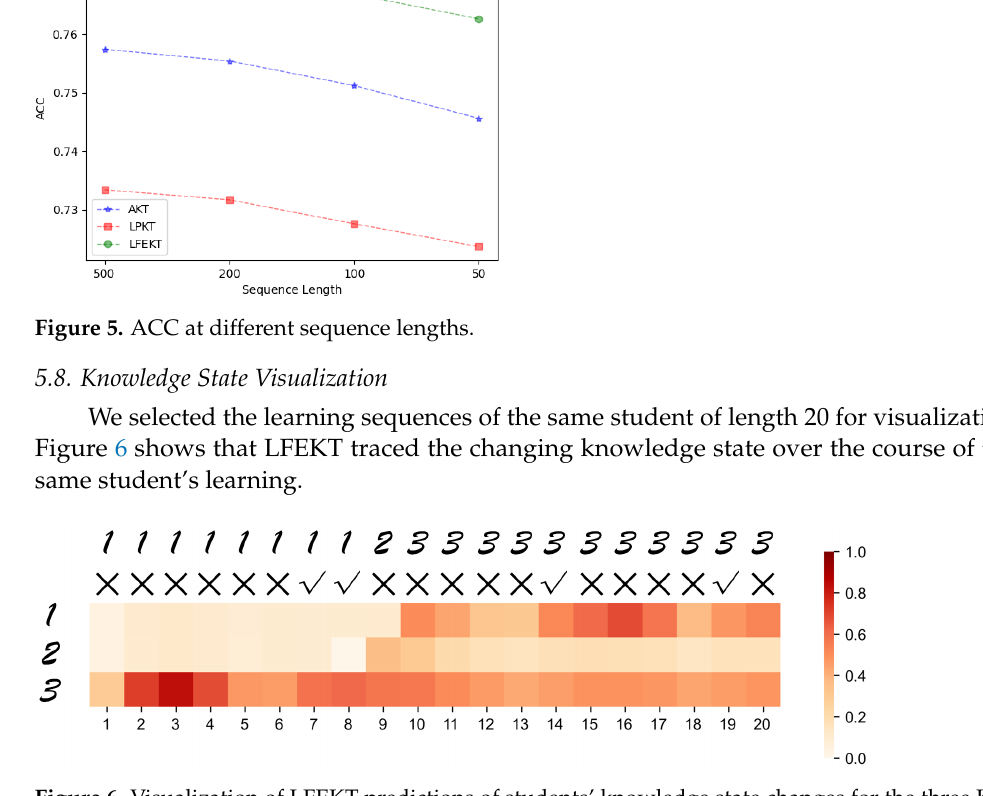
Figure 6. Visualization of LFEKT predictions of students’ knowledge state changes for the three KCs during the learning process. Each serial number represents a different KC included in the exercises. The heat map in the middle is the student’s knowledge state, with darker colors representing better